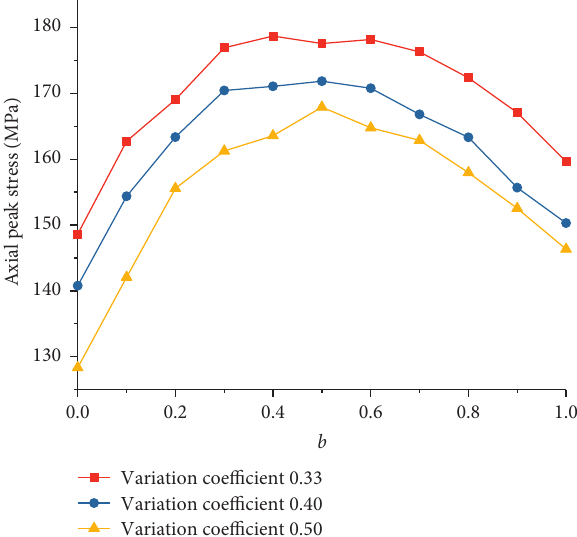
Figure 12: Effect of variation coefficient on the axial peak